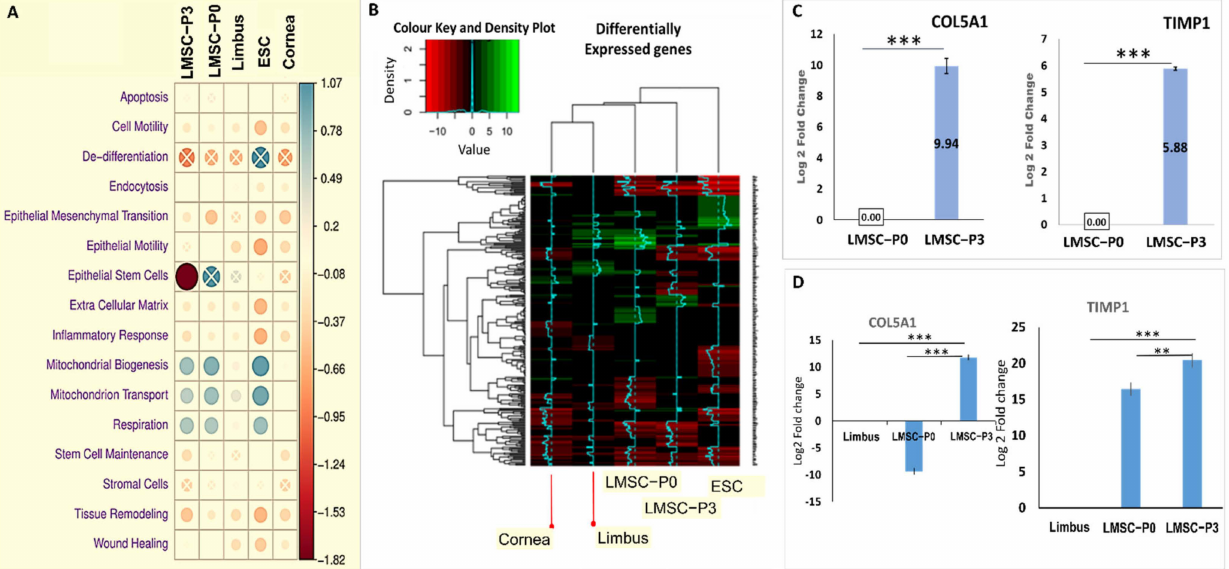
Figure 5. Interpretations from Gene Ontology enrichment analysis. ( A ) Gene ontology pathway- specific analysis: Each row represents the genes belonging to a particular pathway/biological process in the GO database. The dot color/size represents the difference in median expression between genes of a particular pathway and rest of genes in whole transcriptome. A positive value indicates up-regulation (blue) and a negative value indicates down-regulation (red). The difference was tested using Mann–Whitney–Wilcoxon test and statistically insignificant ones were denoted with crosses. Inflammatory response is down-regulated more strongly in P3 versus P0, which may reflect why the use of P3 stage cells does not cause fibrosis in corneal stromal transplants. The stronger down- regulation in ESC may reflect on the immune privilege of embryonic stem cells. The cell motility pathways are active in P3, cornea, and ESC. This is easily explained for the stromal stem cells in P3 and the ESC in terms of their proliferation and migration activity before differentiation, but for cornea may be representative of continuous cell migration required to replace lost corneal tissue. ( B ) The heatmap of 254 genes belonging to wound healing pathway. The rows indicate the genes and columns indicate the samples (cells or tissues). The color intensity represents the level of changes in expression. All significantly up-regulated genes are indicated in green and all significantly down- regulated genes are indicated in red. p < 0.05 was considered to be statistically significant change in the gene expression. ( C , D ) Genes of wound healing pathway exclusively expressed in LMSC − P3: The levels of COL5A1 and TIMP1 in LMSC − P0 and LMSC − P3 assessed through RNA-Seq ( C ) and qRT-PCR ( D ). The LMSC − P3 has ~10-fold ( n = 3. p < 0.001) high expression of COL5A1, which was down-regulated in LMSC − P0, evident from both techniques. The levels of TIMP1 were ~6-fold high ( n = 3, p < 0.001) and 4-fold higher ( n = 5, p < 0.01) in LMSC − P3, when assessed through RNA-Seq and qRT-PCR respectively. ** p < 0.01, *** p < 0.001. The results were plotted as mean log